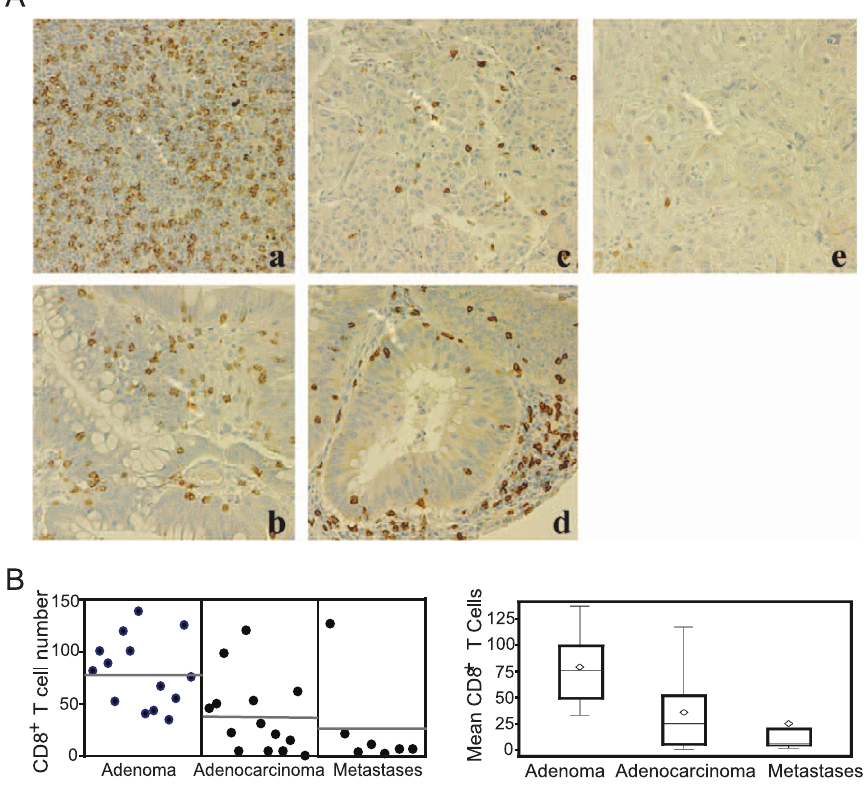
Figure 6. Tumor-infiltrating CD8 + T cells in human colon carcinoma. A . Immunohistochemical staining of CD8 + T cells in human colon cancer specimens. CD8 immunoreactivity is shown as the brown-stained cells, whereas cells that are unreactive are indicated by the blue counterstain. Shown are representative images. a&b: adenoma; c&d: adenocarcinoma; e: liver metastases. B . Quantification of the number of CD8 + T cells in the colon cancer specimens. The number of CD8 + T cells in each specimen printed on the TMA as shown in A was counted. Each dot represents the average number of CD8 + T cells of three sections of the same tumor specimen (left panel). The mean CD8 + T cell number are: adenoma: 79.4, adenocarcinoma: 37.45, and liver/lung metastases: 25.69. Right panel: Statistical analysis of CD8 + T cells between different stages of tumors. One-way analysis of variance was used with a Bonferroni multiple comparison procedure to test for pair-wise post hoc differences between the three types of tumor specimens. Adenoma has a significantly higher mean CD8 + T cells than adenocarcinoma ( p =0.0051) and liver/lung metastases ( p =0.0036). Adenocarcinoma was not significantly different than liver/lung metastases in mean CD8 + T cells ( p =0.4957).